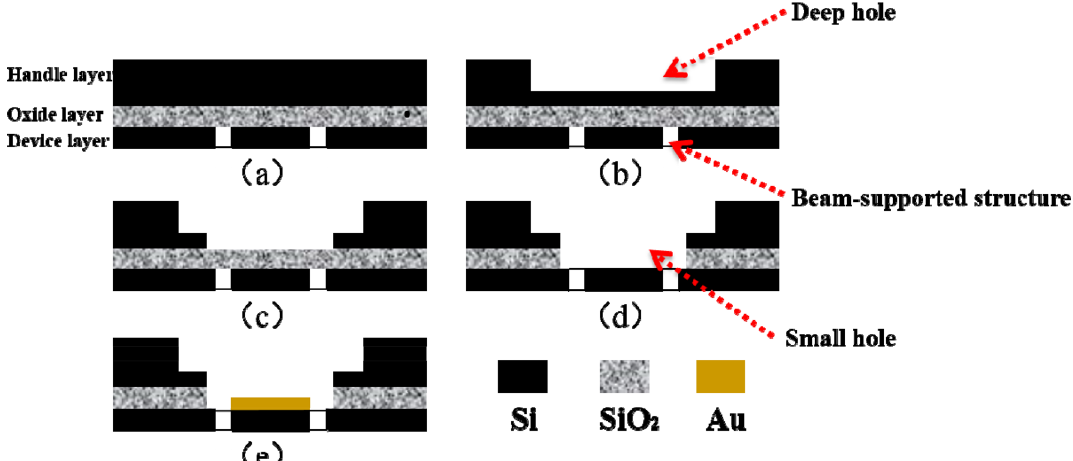
Figure 1. The schematic of manufacturing process for the sensing diaphragm: ( a ) etching beam-supported structure in the device layer of a SOI wafer, ( b ) etching a deep hole in the handling layer, ( c ) etching a small hole in the handling layer, ( d ) removing the oxide layer to free the sensing diaphragm, ( e ) sputtering a gold film on the sensing diaphragm as a reflective